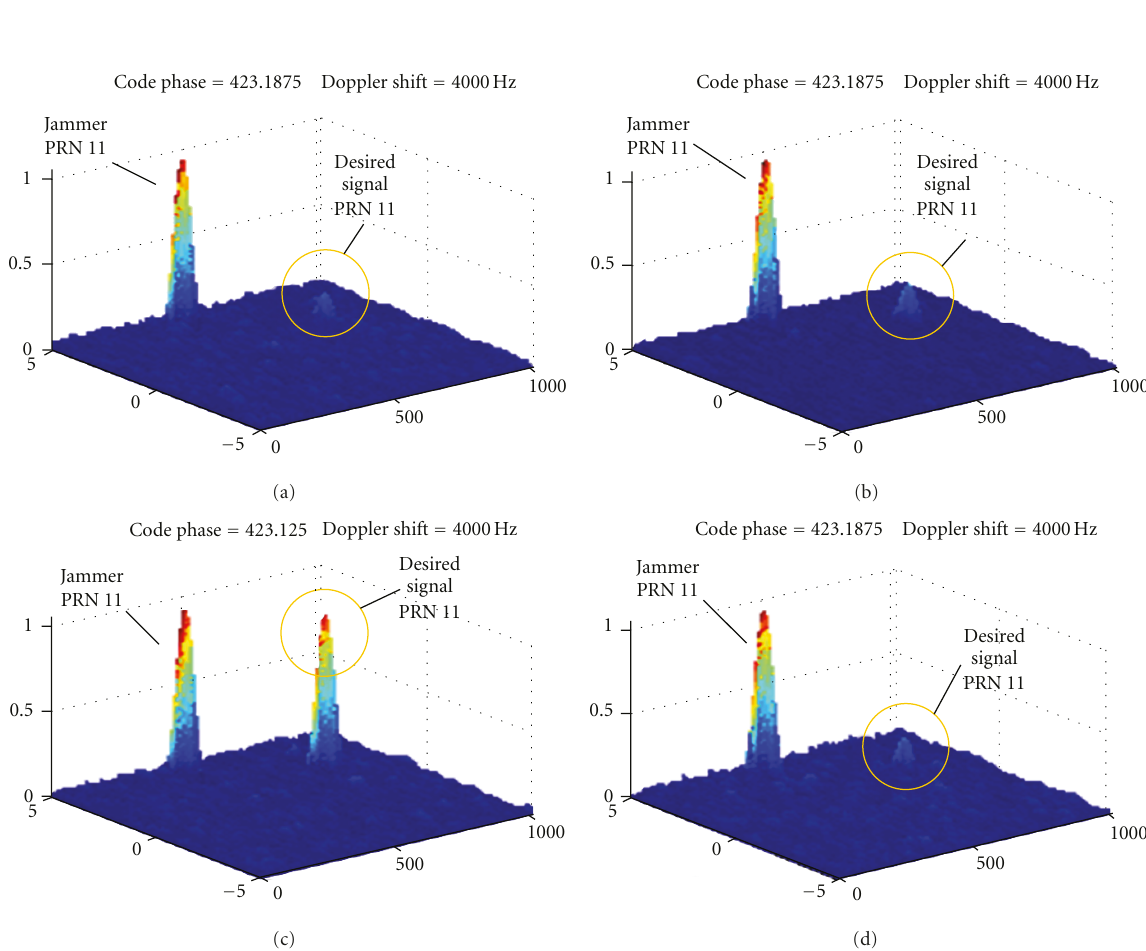
Figure 10: Acquisition result for antenna 1 (a), antenna 2 (b), antenna 3 (c), and antenna 4